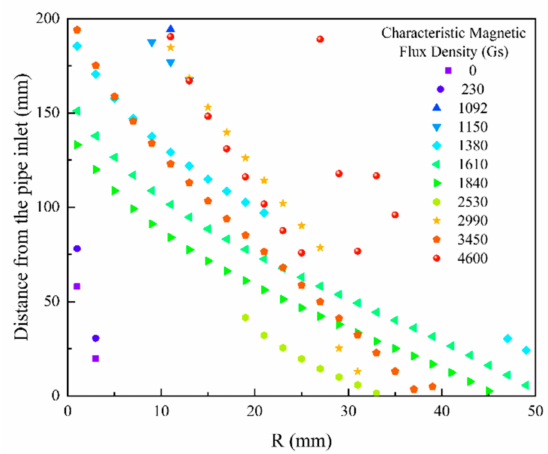
Figure 11. The distance from the pipe inlet of deposited ions with emission angle of 3 ◦ under di ff erent characteristic magnetic flux